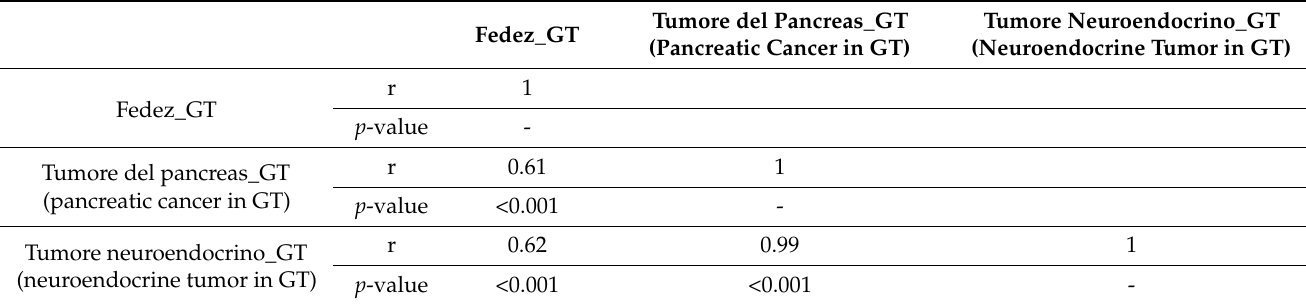
Table 3. Pearson’s correlation coefficient (r) for Google Trends search terms in Italy from 5 December 2021 to 20 November 2022.